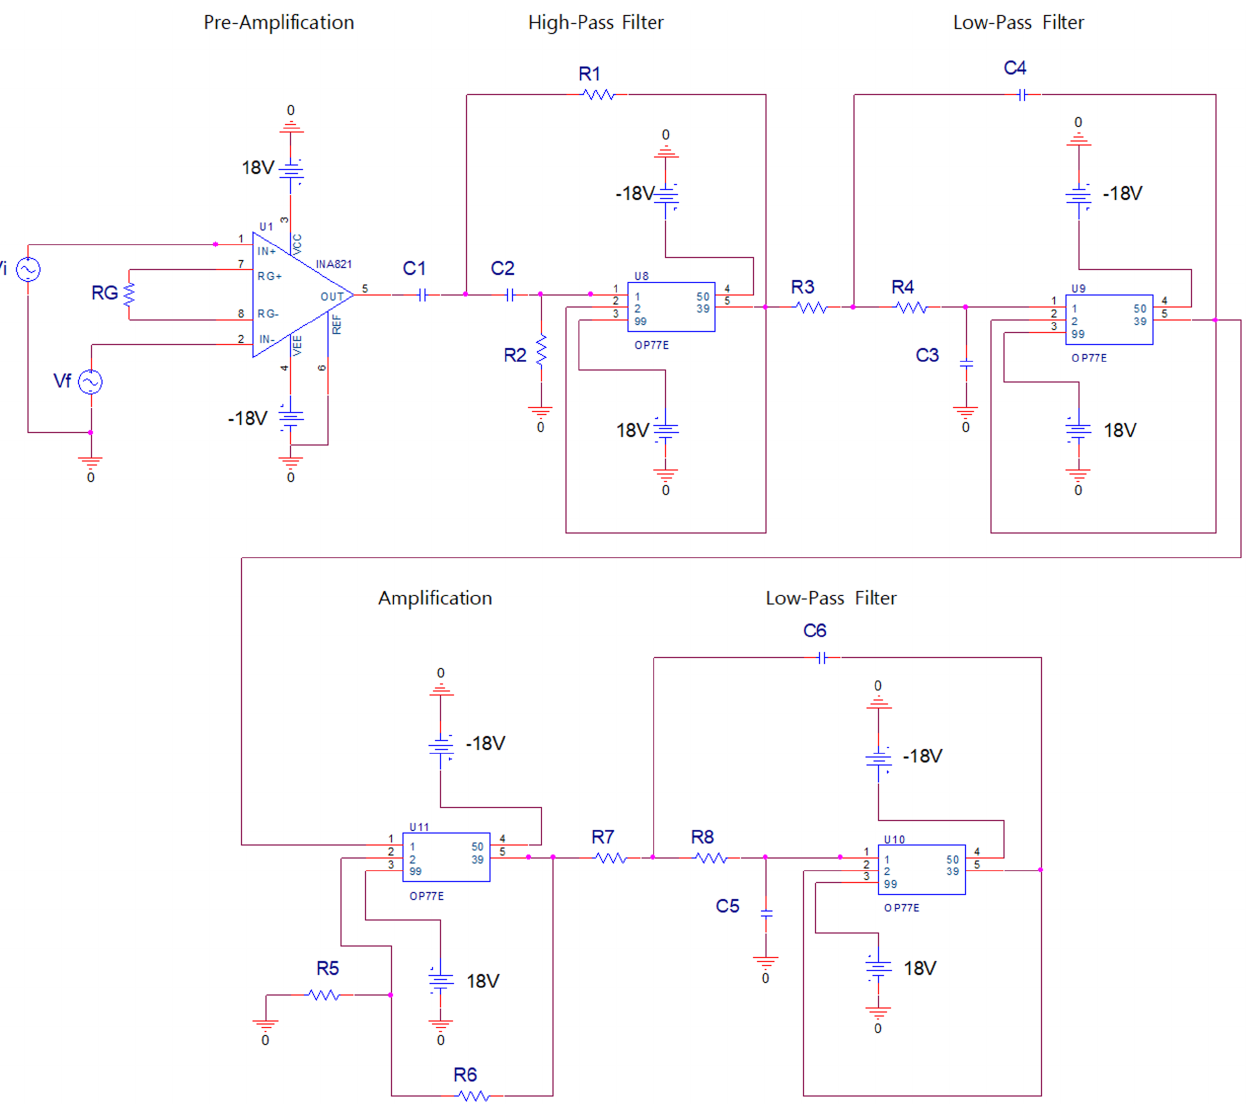
Figure 4. Schematic diagram of the first developed signal conditioning circuit. In the pre-amplification stage, an INA821 instrumentation amplifier is applied. In the high-pass and low-pass filters steps, and in the amplification stage, an OP77 op-amp is employed as